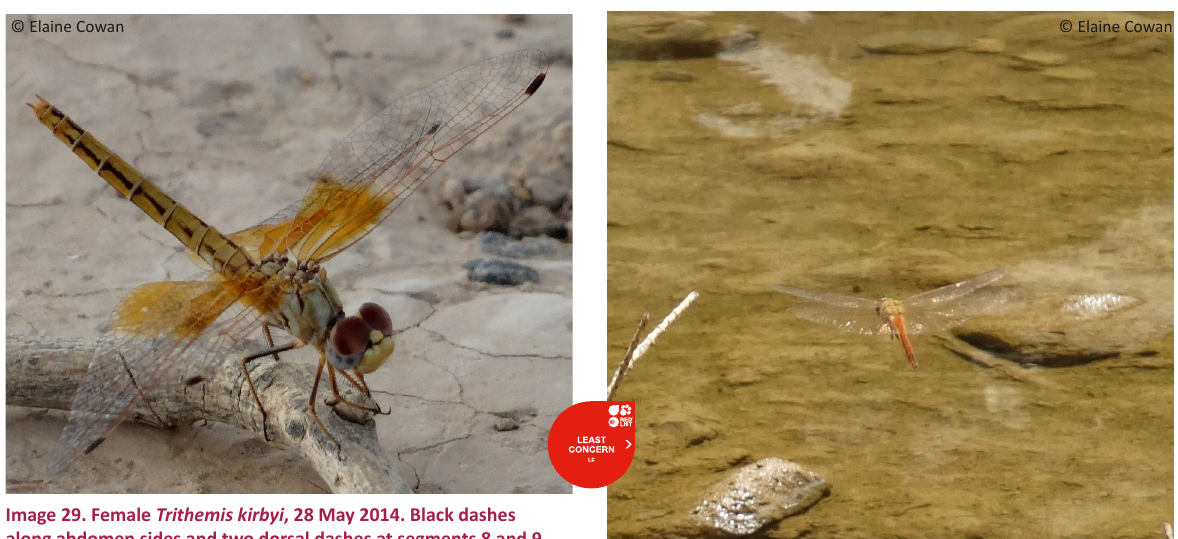
Image 29. Female Trithemis kirbyi , 28 May 2014. Black dashes along abdomen sides and two dorsal dashes at segments 8 and 9. Extensive orange on wings and short dark pterostigmas.